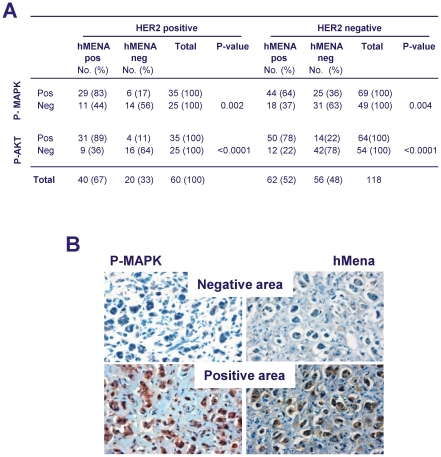
hMena overexpression correlates with the phosphorylated status of MAPK and AKT.
A. The table evidences that in 60 HER2 positive and 118 HER2 negative breast tumors the percentage of P-MAPK and P-AKT positive breast tumors is significantly higher in hMena positive (score 2/3) than in hMena negative breast tumors (score 0/1). B. A representative, although not a paradigmatic case, where P-MAPK displays a heterogeneous immunostaining (40% tumor cells). P-MAPK positivity is mostly confined in the tumor area (positive area) concomitantly showing a strong hMena (score 3) immunoreactivity.